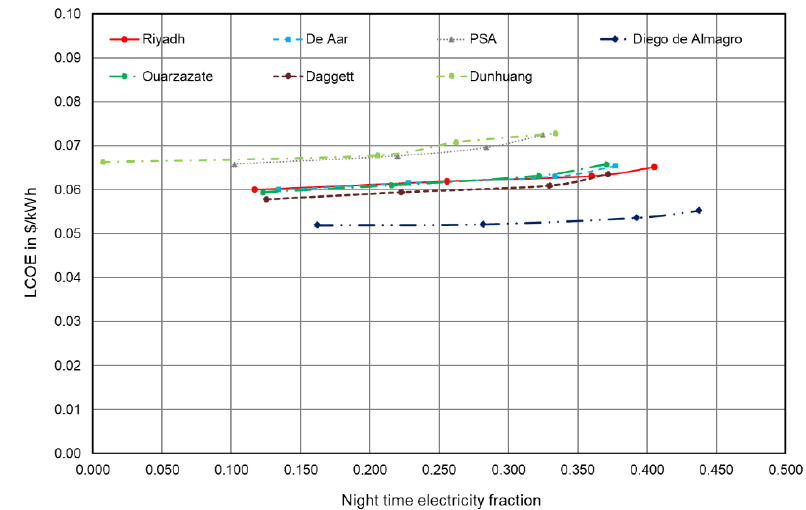
Figure 6. Comparison of locations: tower hybrid.